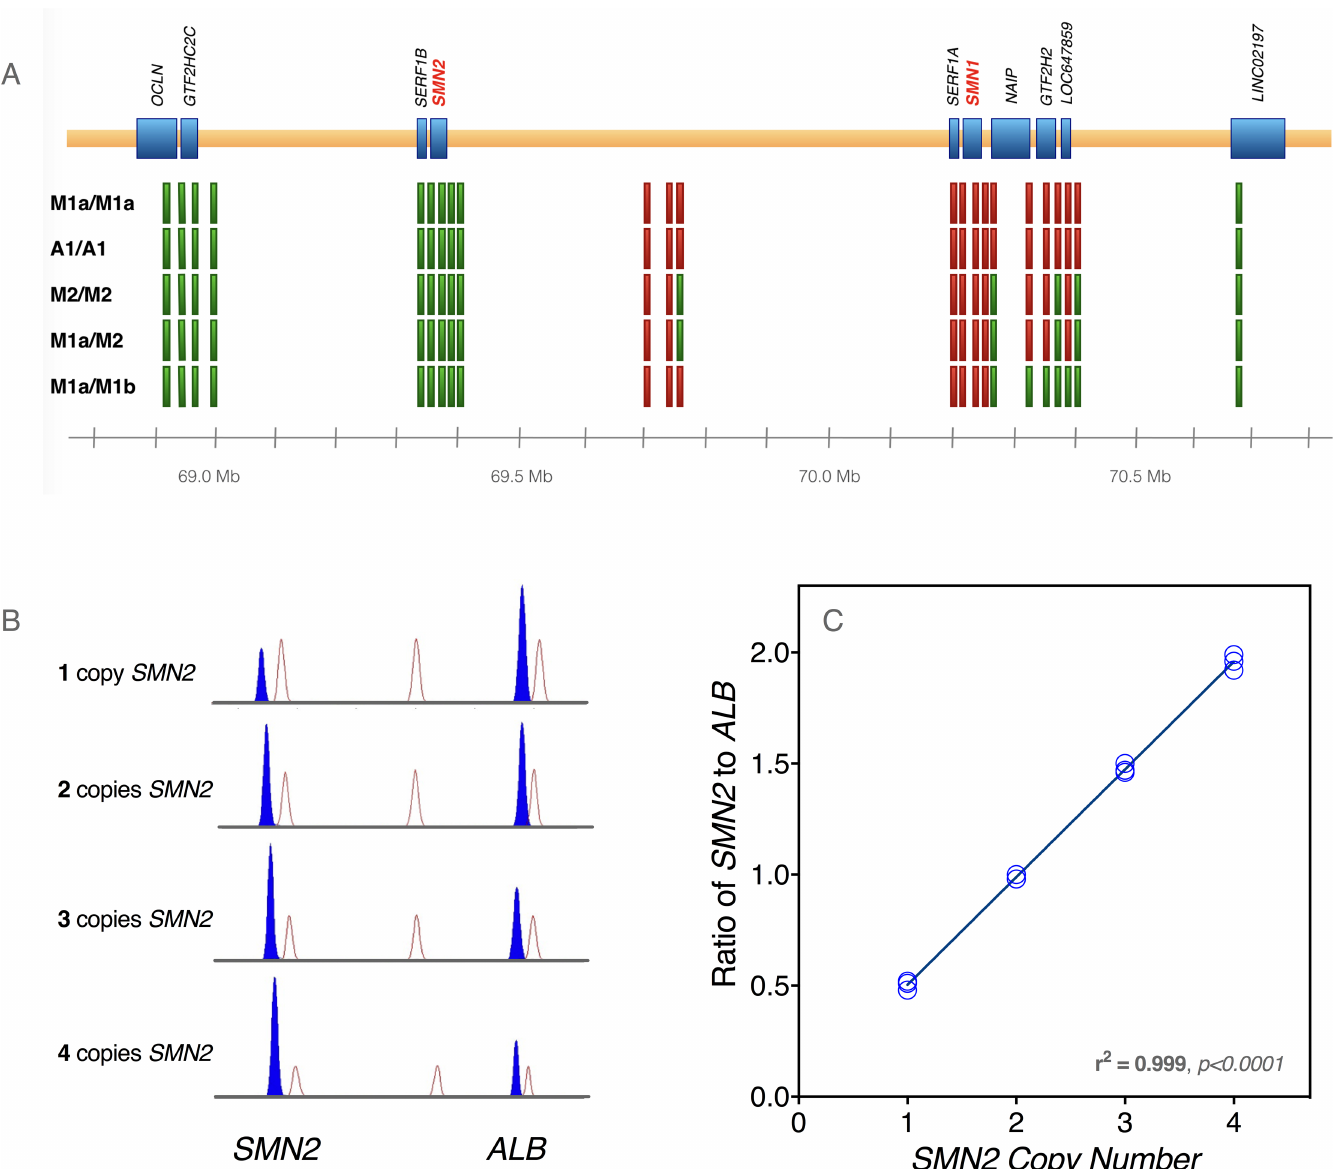
Fig 3. Characterization of SMA haplotypes. (A) To characterize the extent of SMN1 deletions, we performed PCR on loci that mapped to multiple sites in the region. By selecting amplicons which exhibited sequence changes between loci, we were able to assess the presence or absence of each locus after PCR amplification and Sanger sequencing. Green blocks represent loci that were present, and red blocks denote deleted loci. The samples (i.e. haplotype combinations) are listed on the left side of the figure. (B) Competitive PCR was used to calculate SMN2 copy number in our patient cohort. Samples were subjected to multiplex PCR with limiting deoxynucleotide triphosphates and the resulting amplicons were size-fractionated on an ABI 3130 Genetic Analyzer. Samples with greater SMN2 copy number demonstrated increased generation of SMN2 -specific product versus an internal control locus (albumin gene, ALB ). (C) The area under the curve for each amplicon, as provided by the Sequencing Analysis software, was used to calculate the ratio of SMN2 -specific product to ALB product. For SMN2 copy number from 1–4, three separate samples were PCR amplified and analyzed, and the SMN2/ALB ratios were highly correlated with SMN2 copy number.